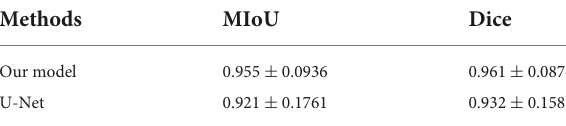
the total number of pixels in both prediction and ground truth.